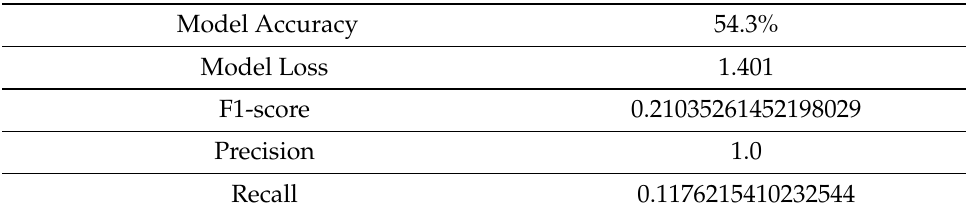
Table 5. Results of LSTM model with commit messages as input.